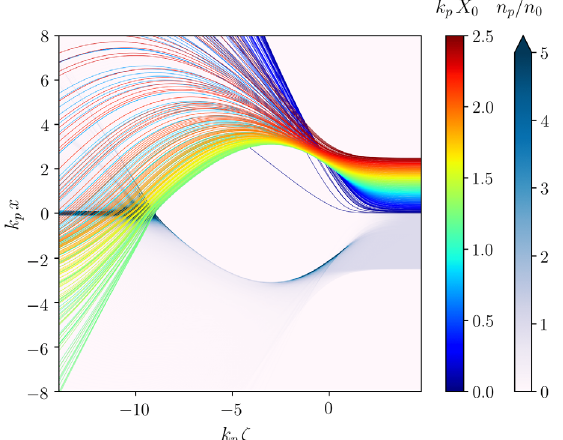
FIG. 1. Plasma electron density, n p =n 0 (blue color scale), and trajectories of plasma electrons with differing impact parameters, k X p 0 (colored lines) in a finite radius plasma with See text for drive beam parameters.